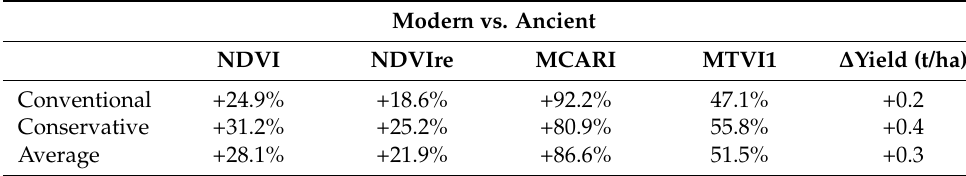
Table 5. Performances of the modern wheat variety ( Anco Marzio ) with respect to the ancient landrace variety ( Saragolla Lucana